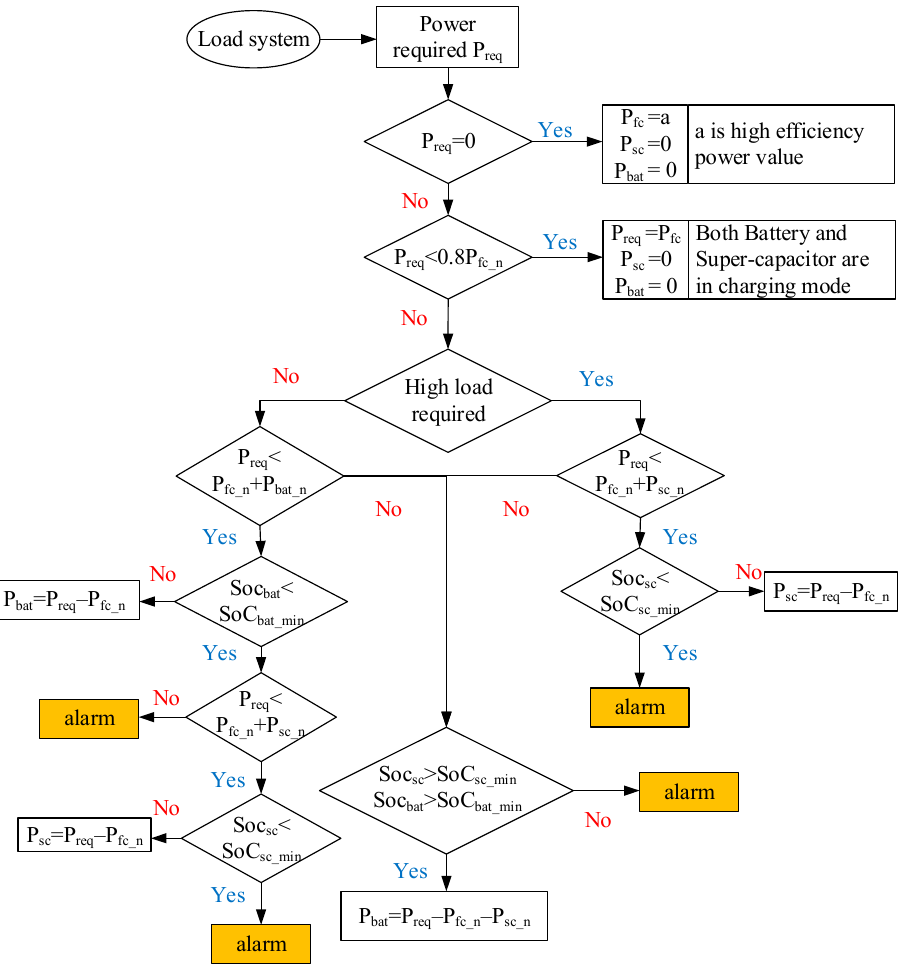
Figure 6. The flow chart of the proposed algorithm.